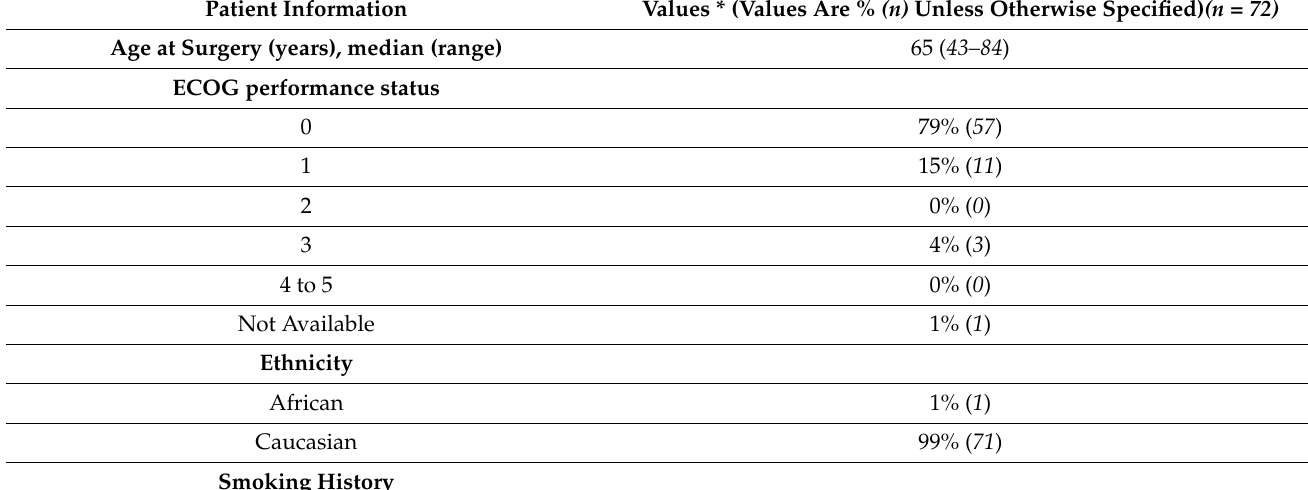
Table 1. Demographic information of the 72 patients included in the